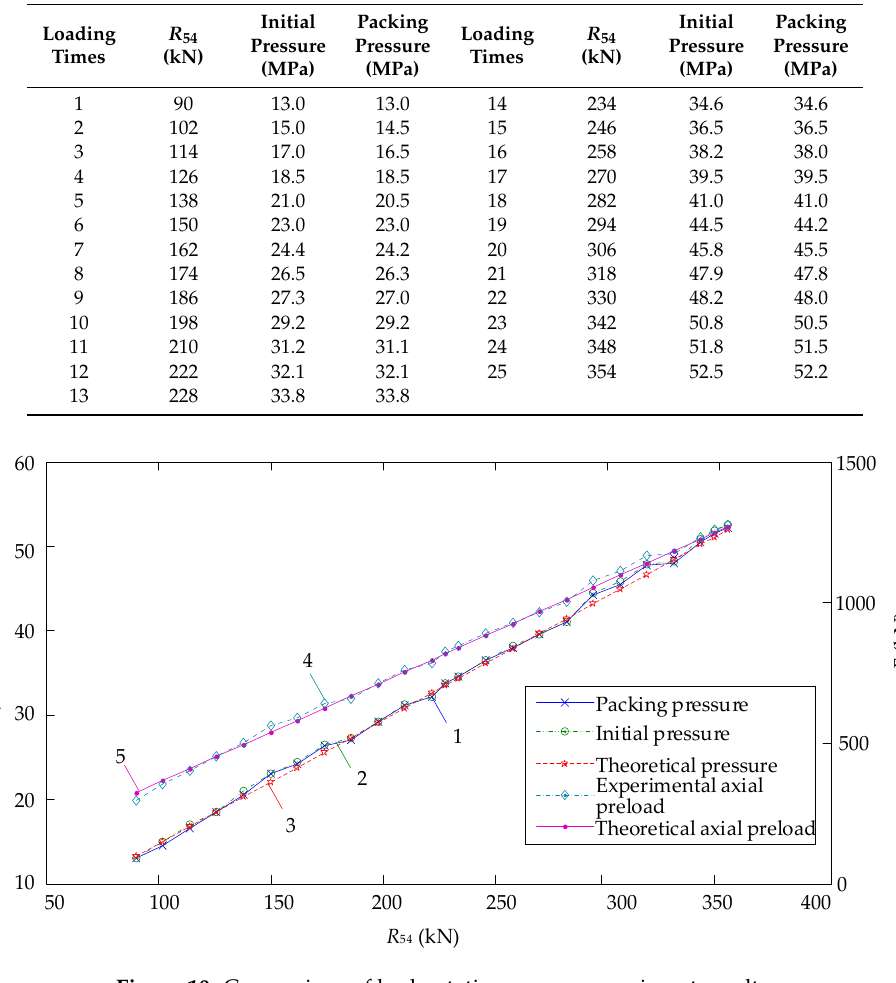
Figure 10. Comparison of hydrostatic pressure experiment results.